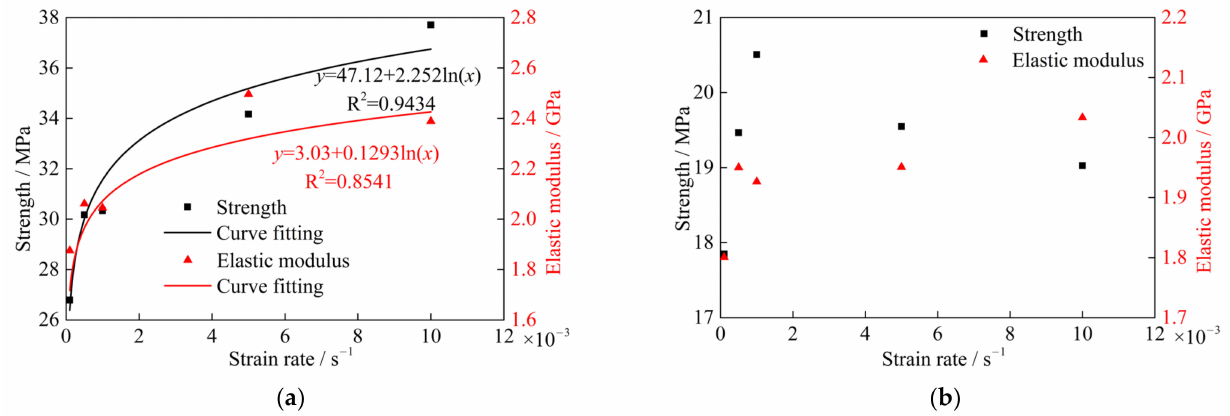
Figure 10. Strength and elastic modulus at different strain rates: ( a ) Specimens with horizontal bedding; and ( b ) Specimens with vertical